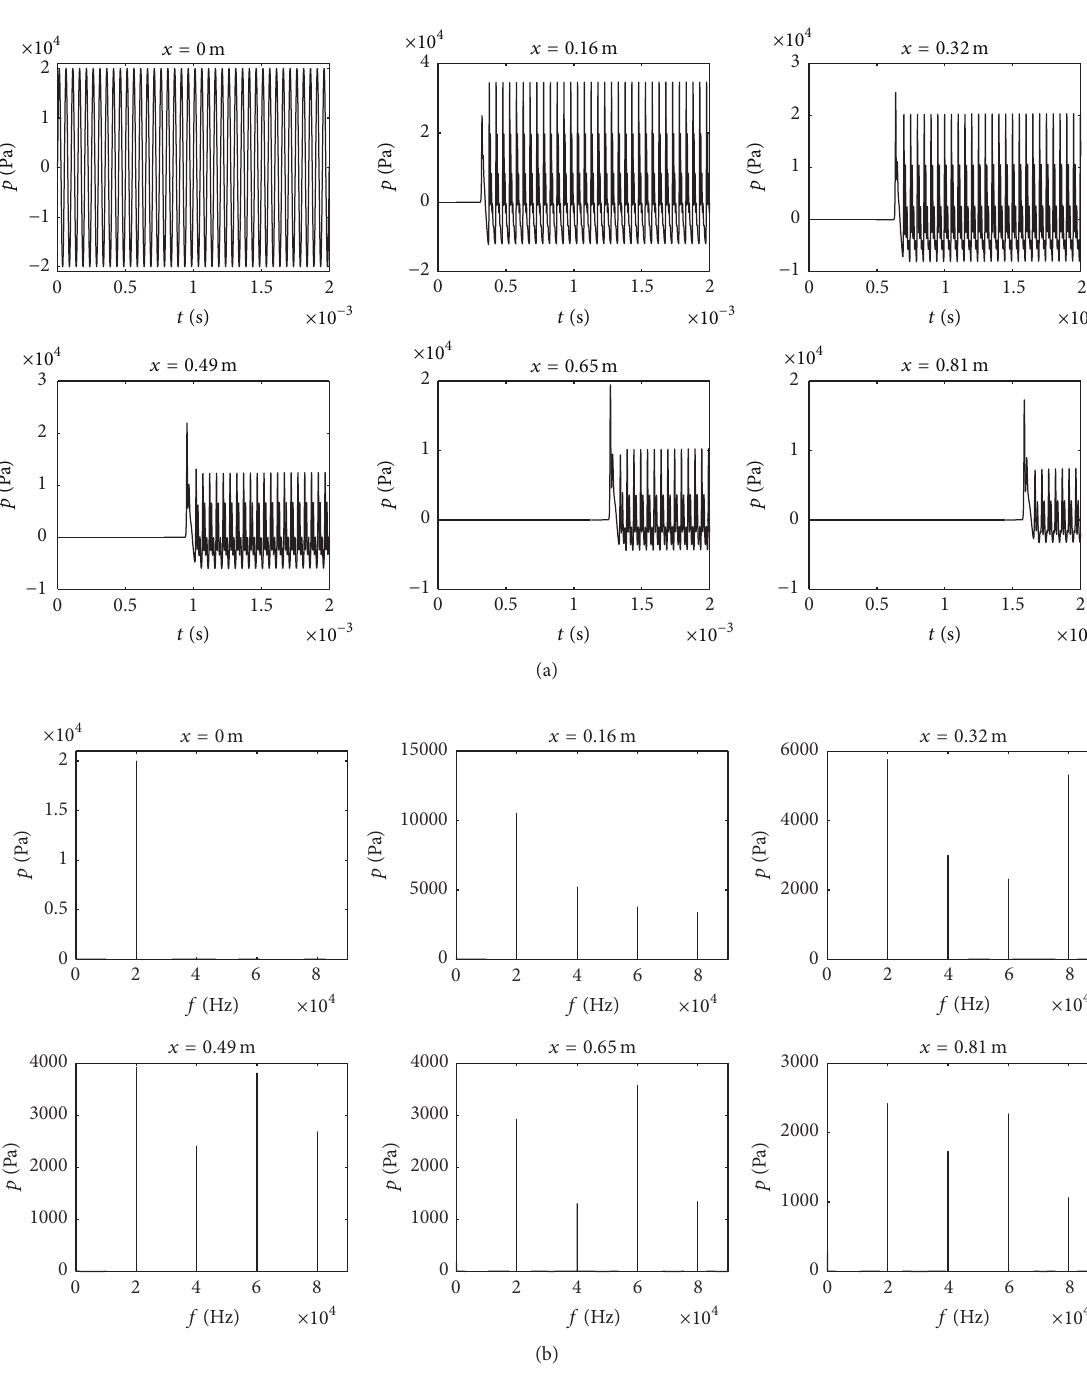
Figure 2: (a) Pressure waveform and (b) frequency content at several distances from the source. Bubble radius is 𝑅 0𝑟 = 7𝜇 m, bubble density is 𝑁 𝑟 = 1 × 10 11 / m 3 , driving frequency is 𝑓 𝑟 = 20 kHz, and pressure amplitude at the source is 𝑝 0 = 20